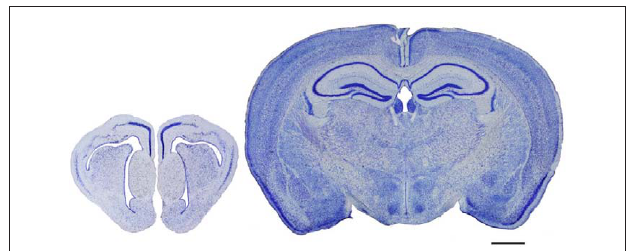
Figure 9 | evolutionary development of the cortex. Photomicrographs of coronal sections (100 μm thick Nissl-stained sections) of the telencephalon of a reptile (gecko, left) and a mammal (mouse, right), illustrating the evolutionary development of the cortex. Scale bar: